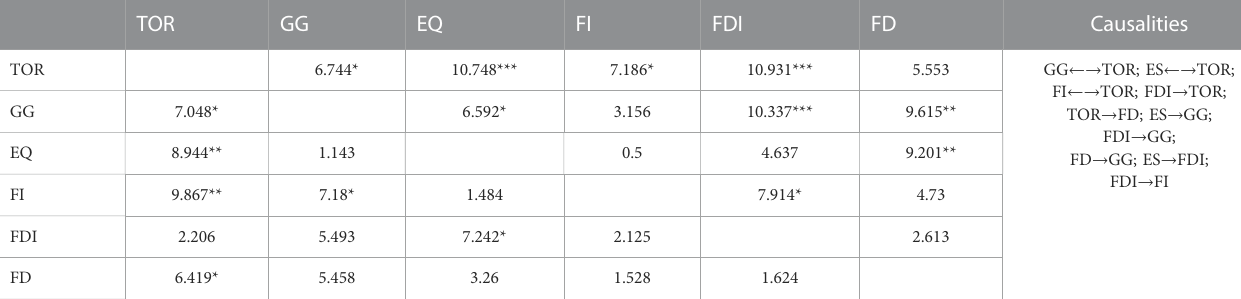
TABLE 11 Results of the Toda-Yamamoto casualty test.